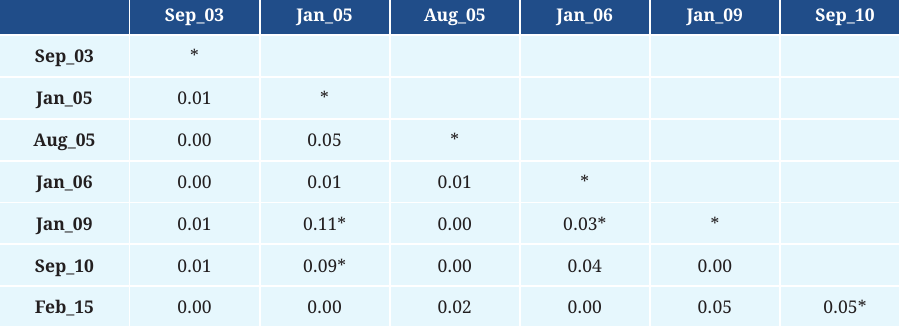
TABLE 2 | Analysis of F coupled with Prochilodus lineatus collected along the period of 2003 to 2015 ST obtained with the D-loop marker. * Statistically significant values at the level of